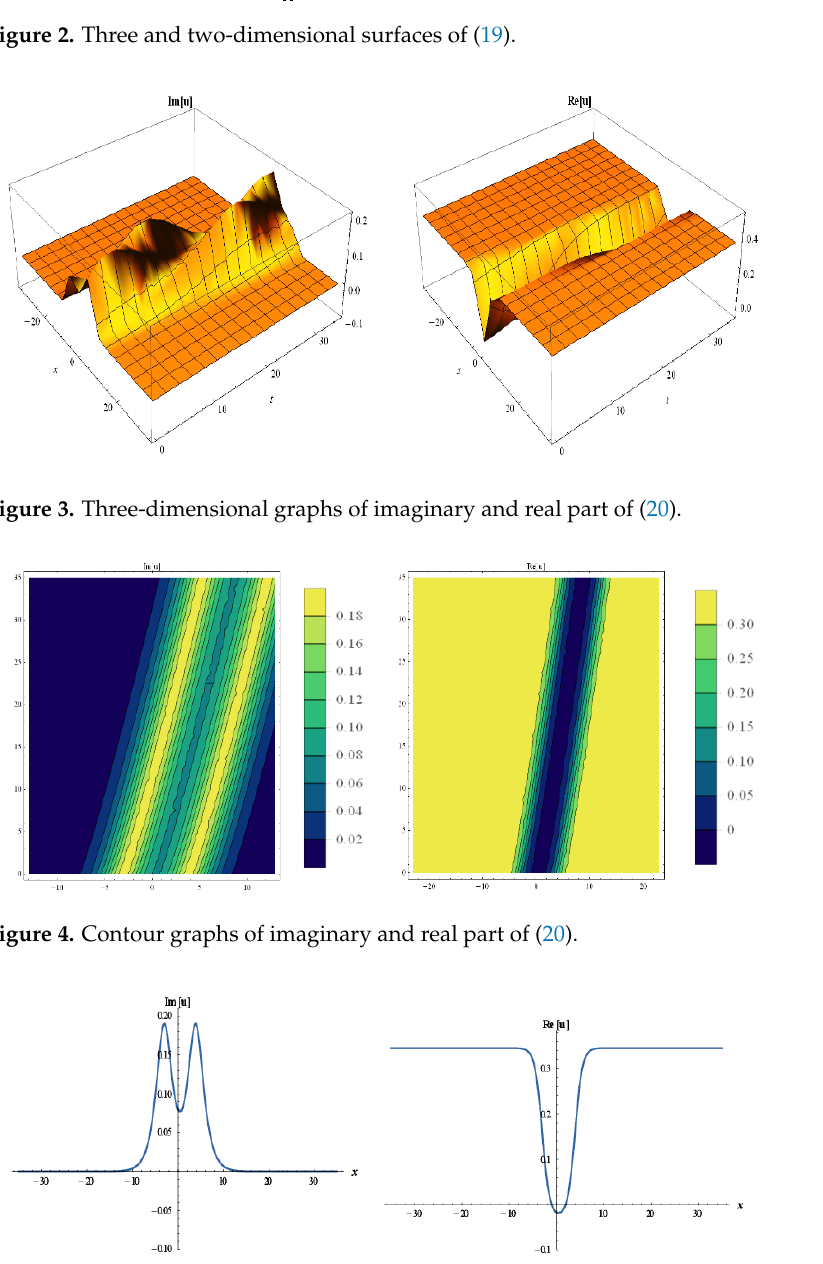
Figure 5. Two-dimensional graphs of imaginary and real part of